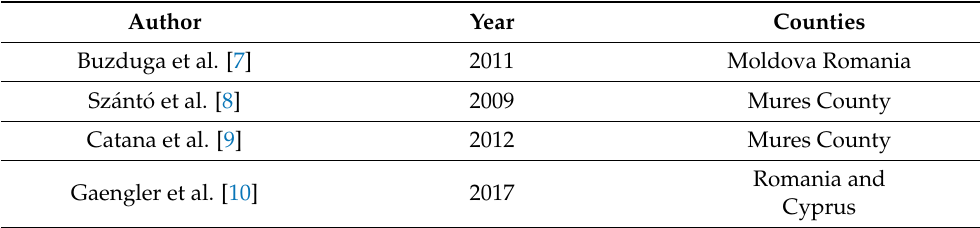
Table 1. Studies on iodine deficiency related to thyroid carcinoma in Romania.